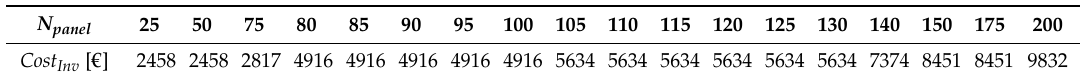
Table 6. Indicative SMA SUNNY TRIPOWER x000 TL inverters total cost Cost Inv ( € ) per PVs population N panel [66].